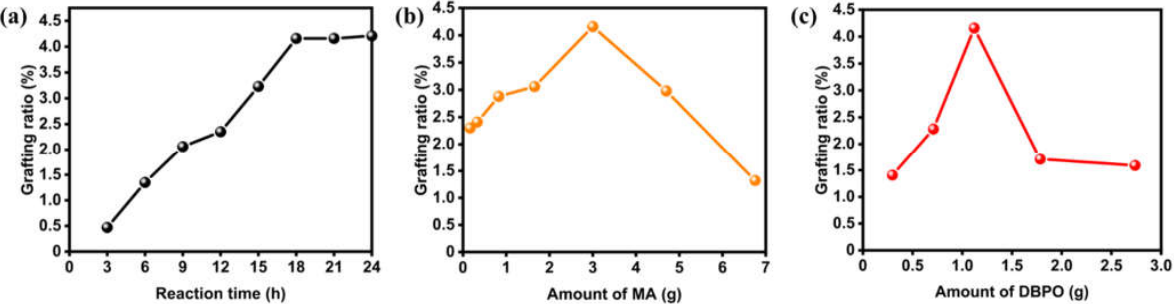
Figure 3. Grafting ratios of PCL-g-MA synthesized with different ( a ) reaction periods, ( b ) amounts of MA and ( c ) amounts of